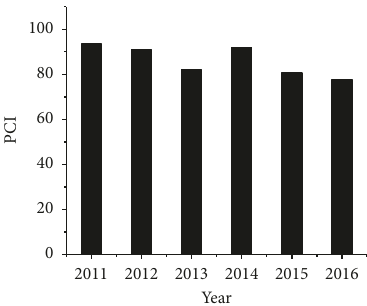
Figure 1: Continuous chart of the road condition index.